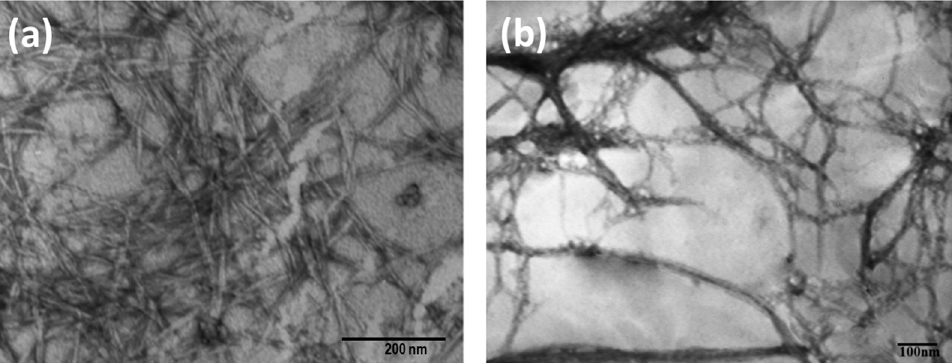
Figure 2. TEM Image of ( a ) CNC from acid hydrolysis (with permission from Carbohydrate Polymers) and ( b ) CNF from Ultra Turrax.